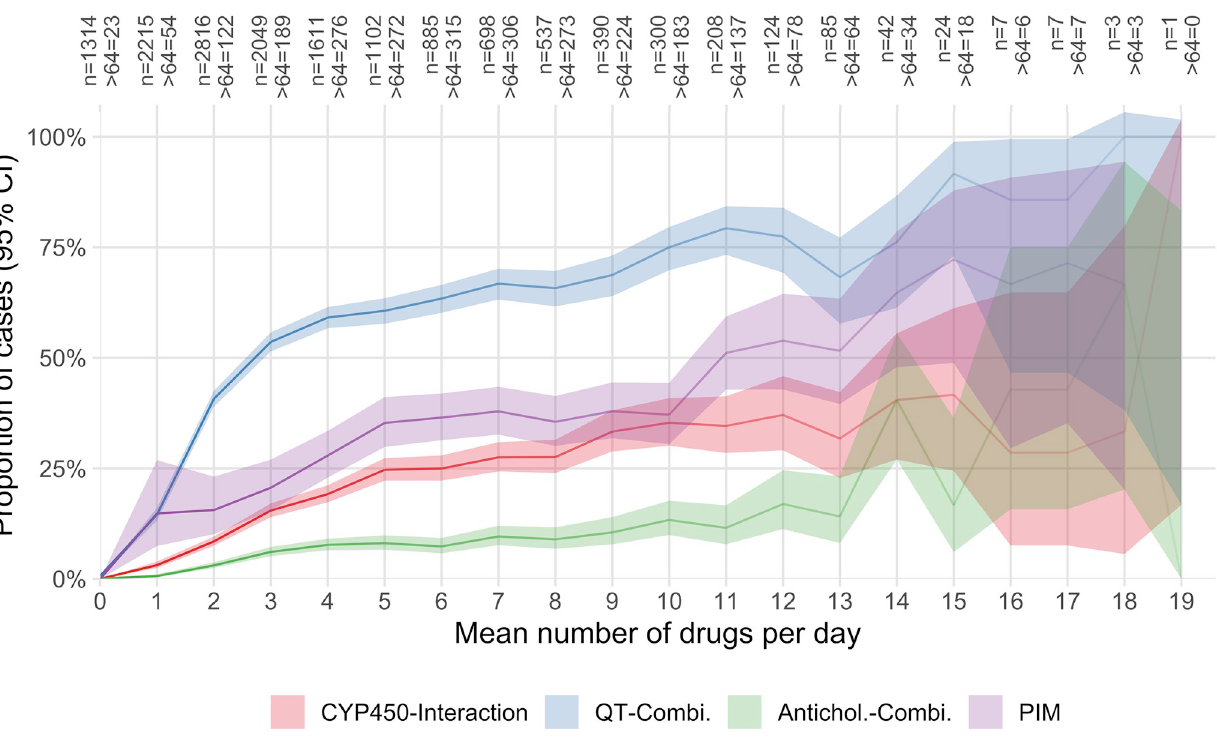
Fig 2. Mean number of drugs per day and the proportion of cases with at least one pDDI or PIM during their stay. CYP450-Interaction: Pharmacokinetic cytochrome P450 (CYP)-mediated drug-drug interaction. QT-Combi.: A combination of at least two drugs on the same day with known or possible risk of TdP. Antichol. Combi.: A combination of at least two drugs on the same day with at least moderate anticholinergic activity. PIM: Potentially inappropriate medication in the elderly. > 64: Number of cases of more than 64 years of age at